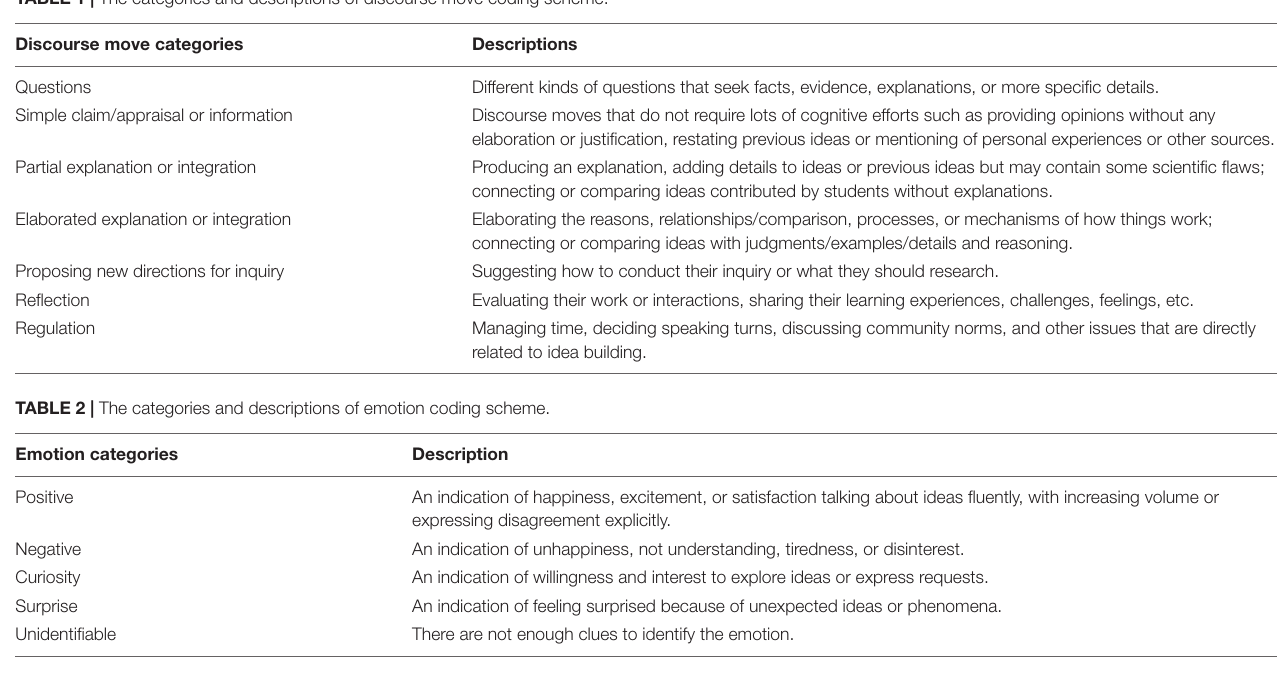
TABLE 1 | The categories and descriptions of discourse move coding scheme.